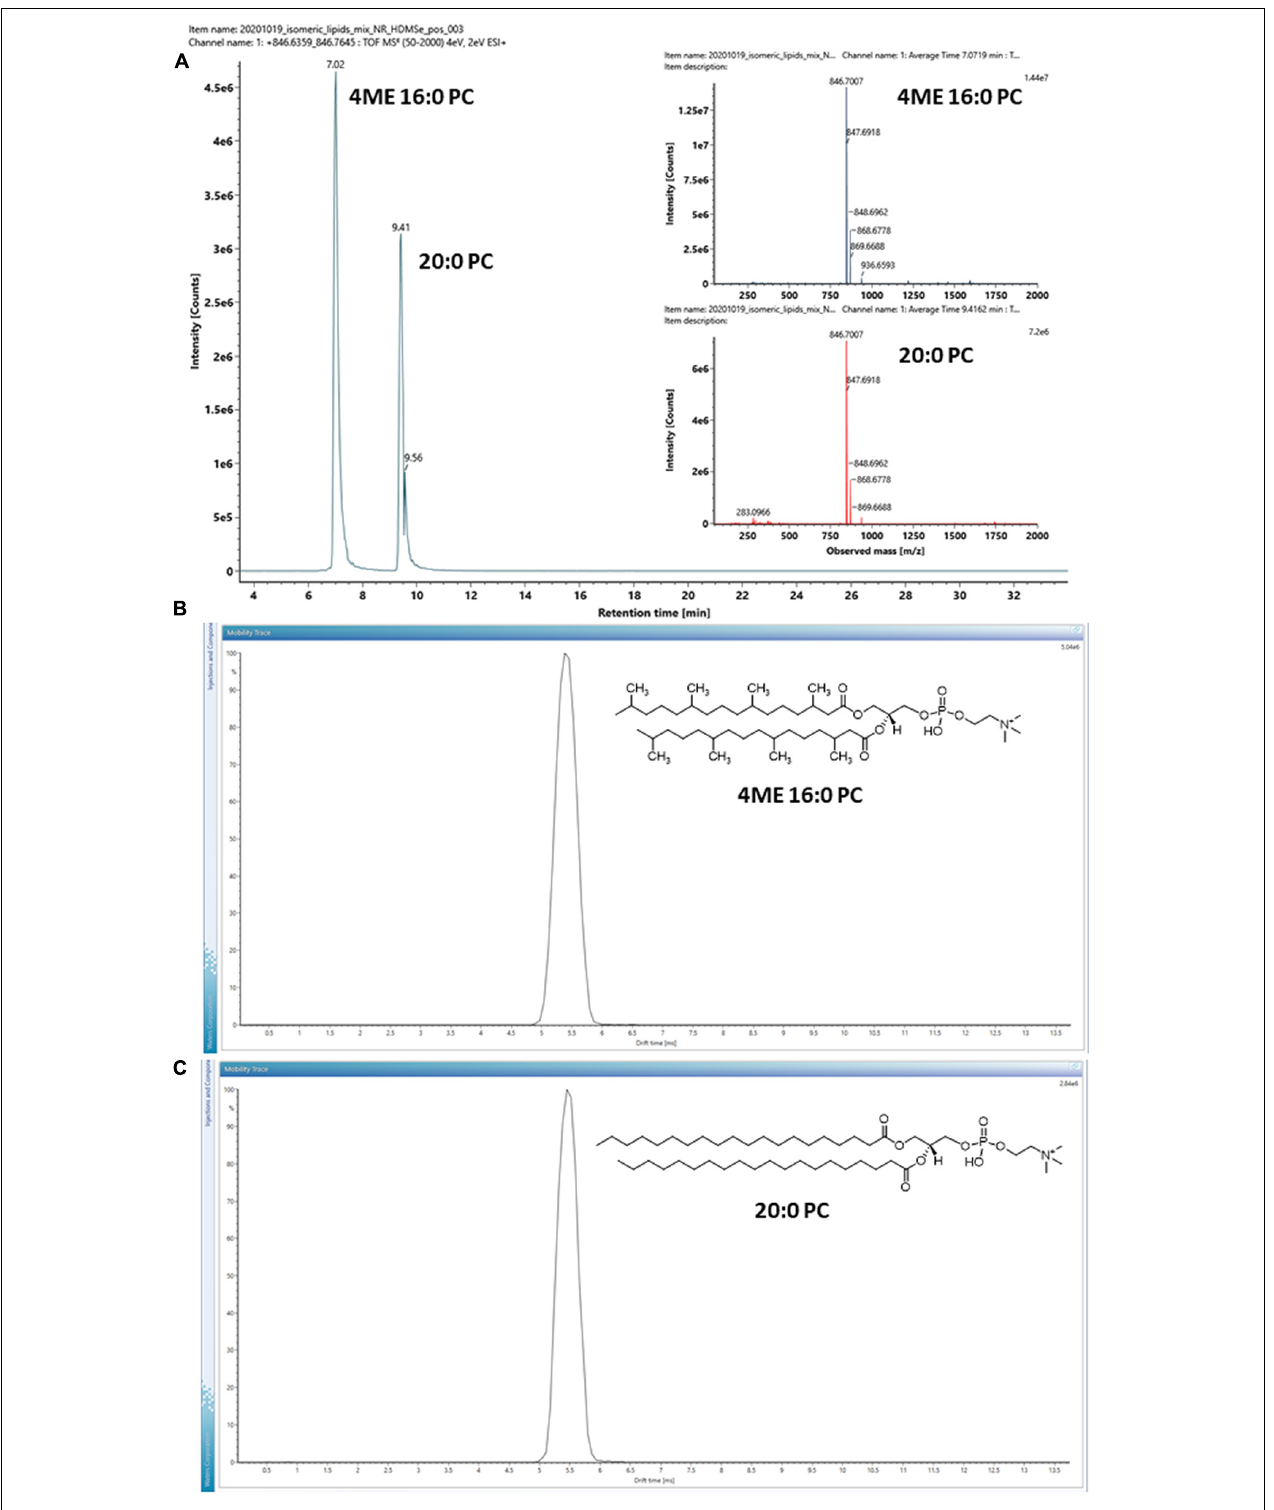
FIGURE 3 | (A) EIC of a pair of isomeric lipids, 1,2-diphytanoyl- sn -glycero-3-phosphocholine (4ME 16:0 PC) and 1,2-diarachidoyl- sn -glycero-3-phosphocholine (20:0 PC) analyzed under positive ion mode. Inserts are MS 1 mass spectra of the isomeric lipid pair. (B,C) Arrival time distributions of the protonated form [M + H] + of the isomeric pair. Inserts show their chemical structures. The arrival time distributions are almost identical, despite the differences in their hydrocarbon tails.